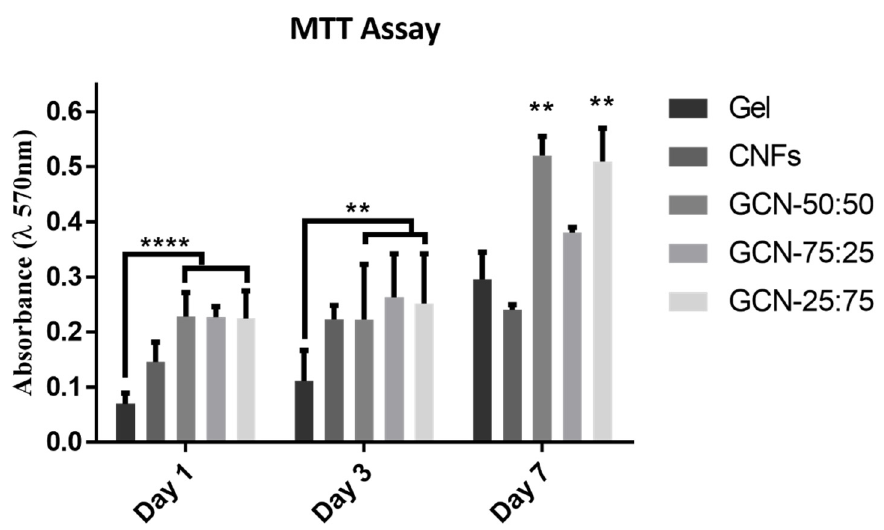
Figure 7. Quantitative cell viability analysis performed with MTT assay. Absorbance registered at 570 nm is directly related to the number of metabolically active cells. Time points at 1, 3 and 7 days after after seeding. For each time point **** p ≤ 0.0001; ** p ≤ 0.01. seeding. For each time point **** p ≤ 0.0001; ** p ≤ 0.01.